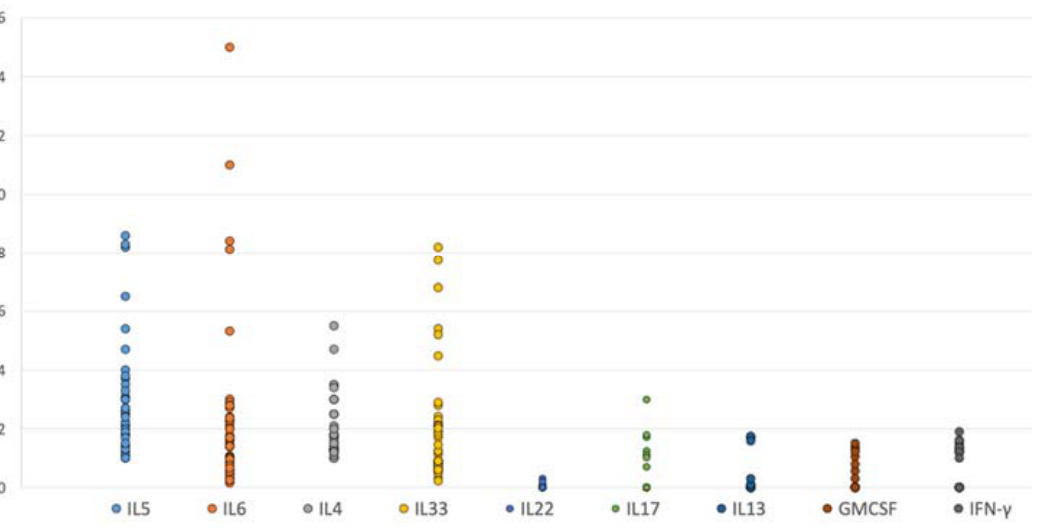
Figure 1. Mean levels of cytokines. Histogram showing the mean levels of cytokines in the overall population, measured in ng/L.